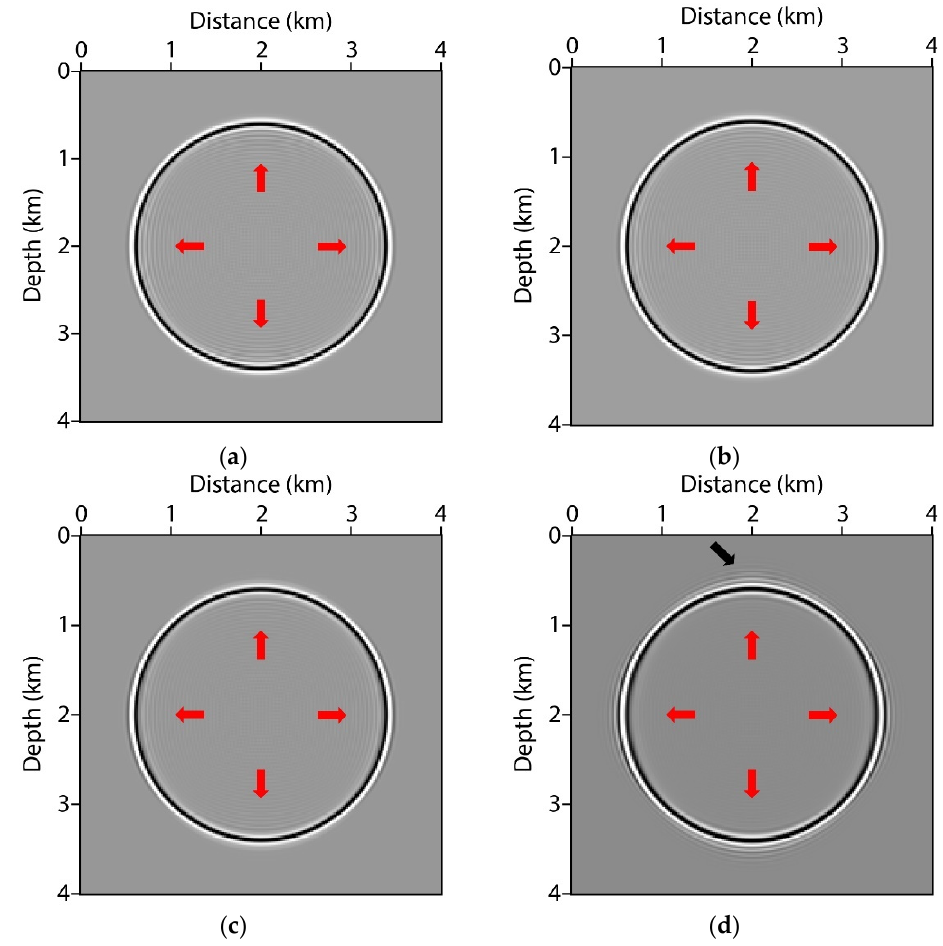
Figure A2. Snapshots of the homogeneous model at 0.5 s. They are simulated by: ( a ) CFD8 scheme, ( b ) OCFD8 scheme (0.5 π ), ( c ) OCFD8 scheme (0.75 π ), and ( d ) OCFD8 scheme ( π ), respectively. The red arrows indicate spatial dispersion and the black arrow indicates the temporal dispersion.